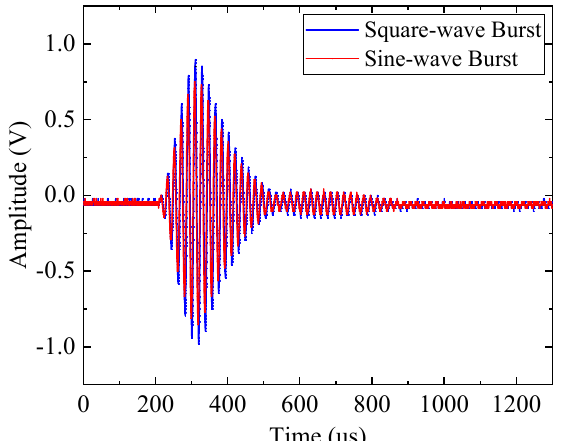
Figure 9. Transmitting signal of the CMUT excited by the square-wave and sin-wave bursts.